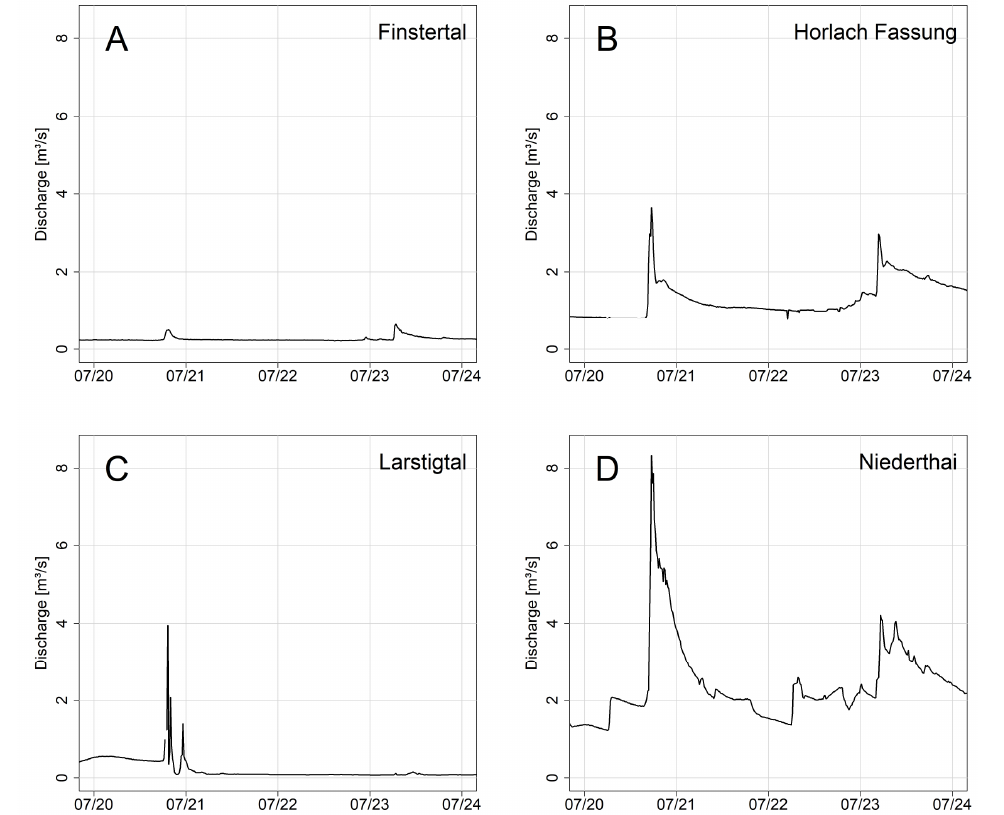
Figure 8. Discharge measurements at the four gauges ( A – D ) in Horlachtal during the events in July 2022.